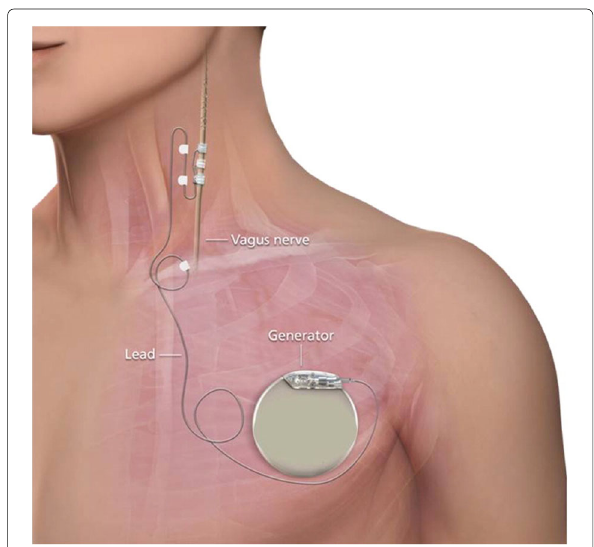
Fig.2 Implantable Vagus Nerve Stimulation Device (Verrier et al. 2016)